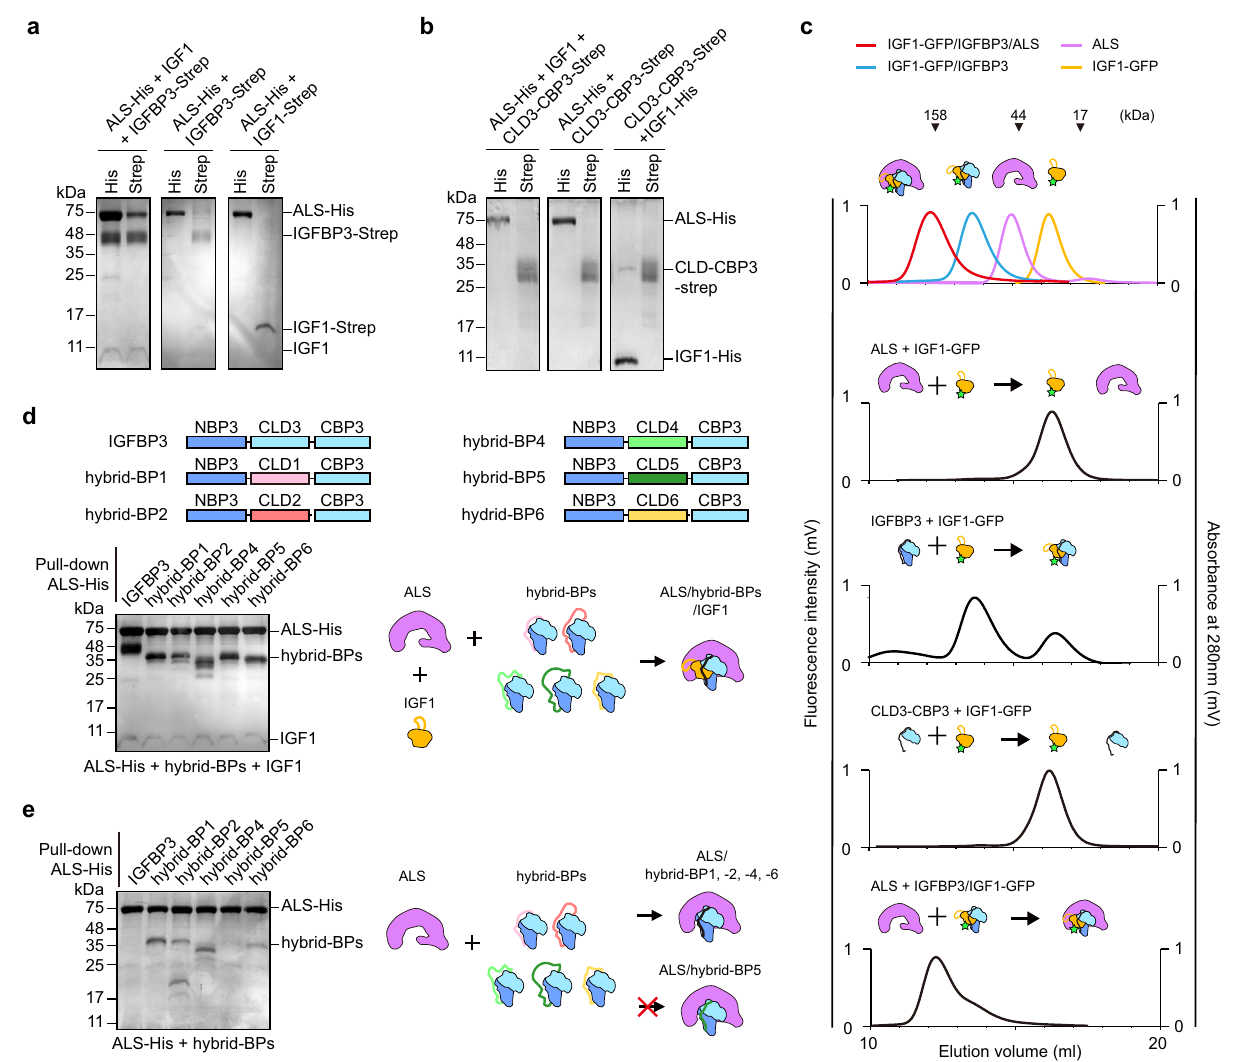
Fig. 5 | Critical role of CLD3 for sequential assembly of IGF1/IGFBP3/ALS tern- arycomplex.a SDS-PAGEanalysisoftheco-expressiontest.ALS-His,IGFBP3-Strep, and IGF1 (IGF1 or IGF1-Strep) are co-expressed and pulled down with Ni-NTA or Strep-Tactin resin, as indicated. b Co-expression of CLD3-CBP3 with ALS and/or IGF1.ALS-His, CLD3-CBP3-Strep,and IGF1(IGF1orIGF1-His)wereco-expressedand pulled down with Ni-NTA or Strep-Tactin resin, as indicated. c Fluorescence- detection size-exclusion chromatography (FSEC) after in vitro reconstitution of indicated proteins. Fluorescence signal (GFP) fused to IGF1 was monitored to examine the complex formation. The elution pro fi les for standard IGF1-GFP